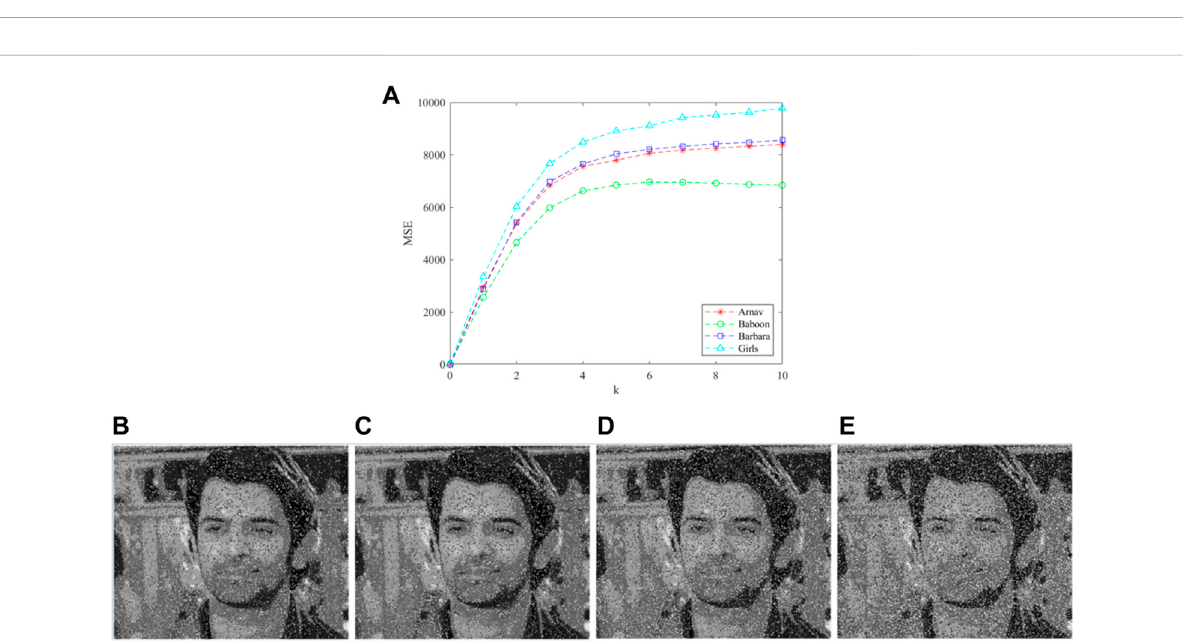
FIGURE 19 Results of noise attack: (A) MSE curve, noise intensities: (B) k (cid:4) 2, (C) k (cid:4) 4, (D) k (cid:4) 6, (E) k (cid:4) 8.